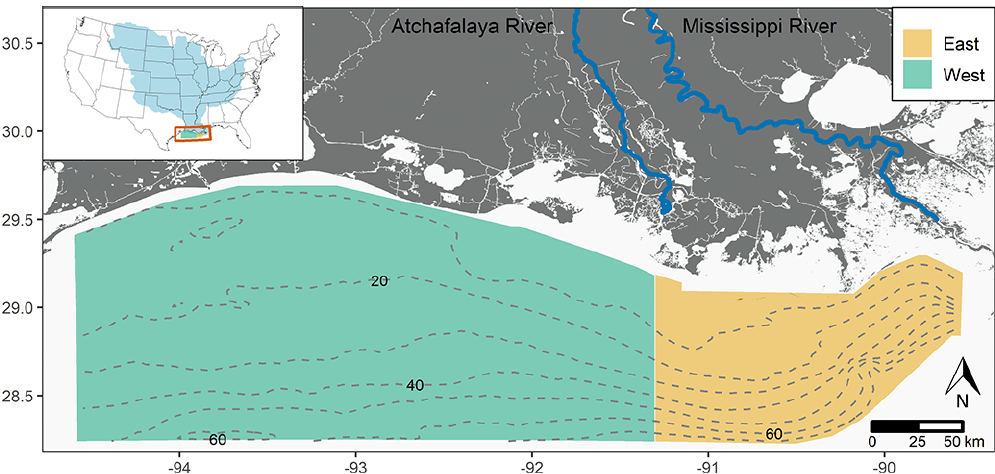
Figure 1. Map of the study area located in the northern Gulf of Mexico. The Mississippi and Atchafalaya river basin (top left; light blue filled) is used to estimate monthly precipitation and temperature. Dashed gray lines indicate isobaths